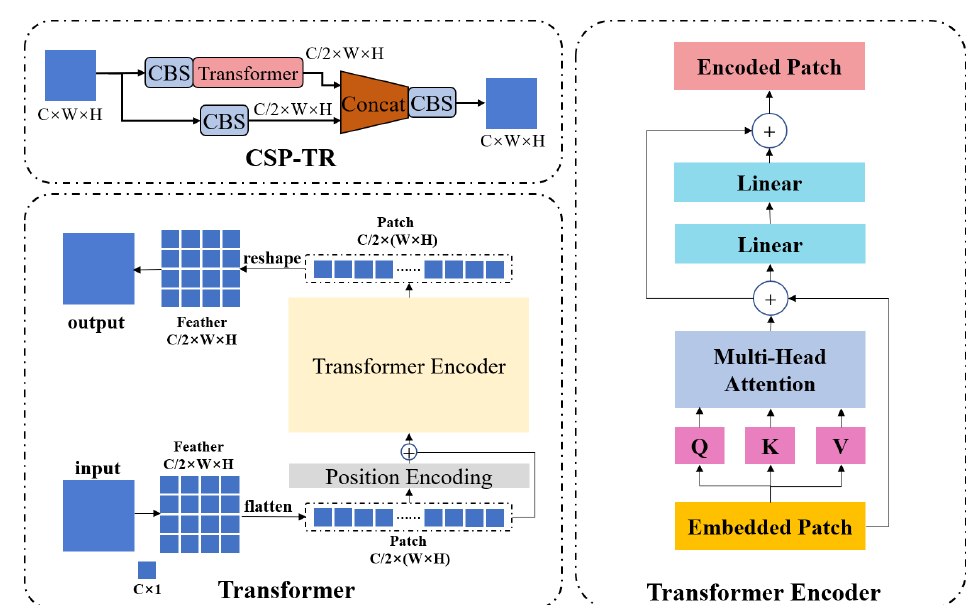
Figure 3. Detailed structure of the CSP-TR